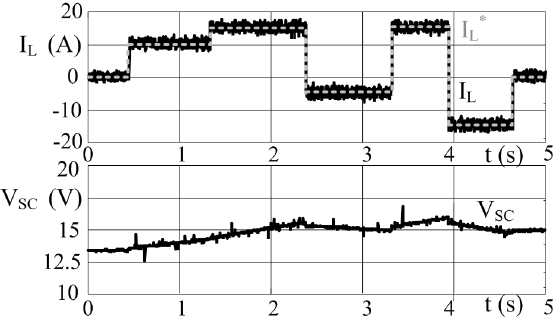
Figure 22. Inductor current I L (black, upper plot) and supercapacitor (SC) voltage V SC (black, lower plot) during step changes in the commanded current I ∗ current corresponds to charging mode, negative to discharging